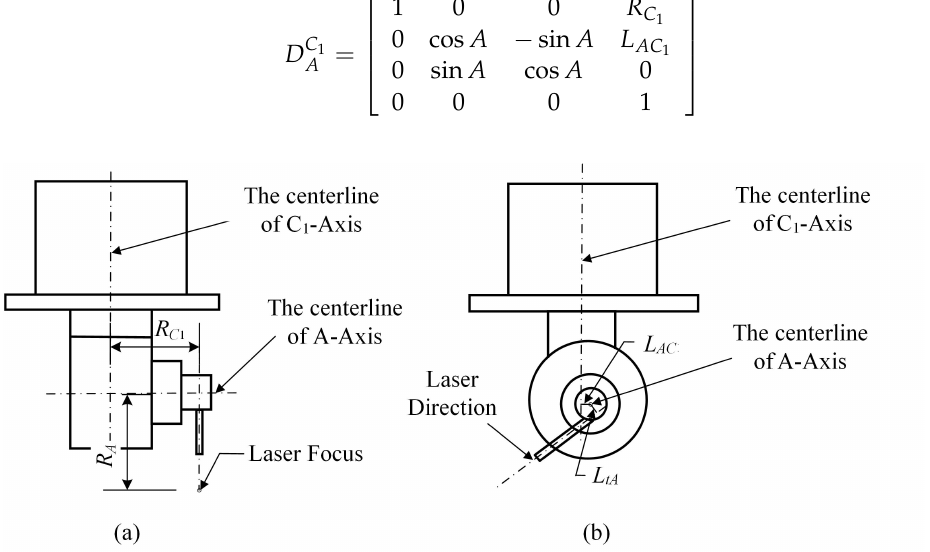
Figure 4. Schematic diagram of linkage parameters. ( a ) The front view of the double swing structure. ( b ) The side view of the double swing